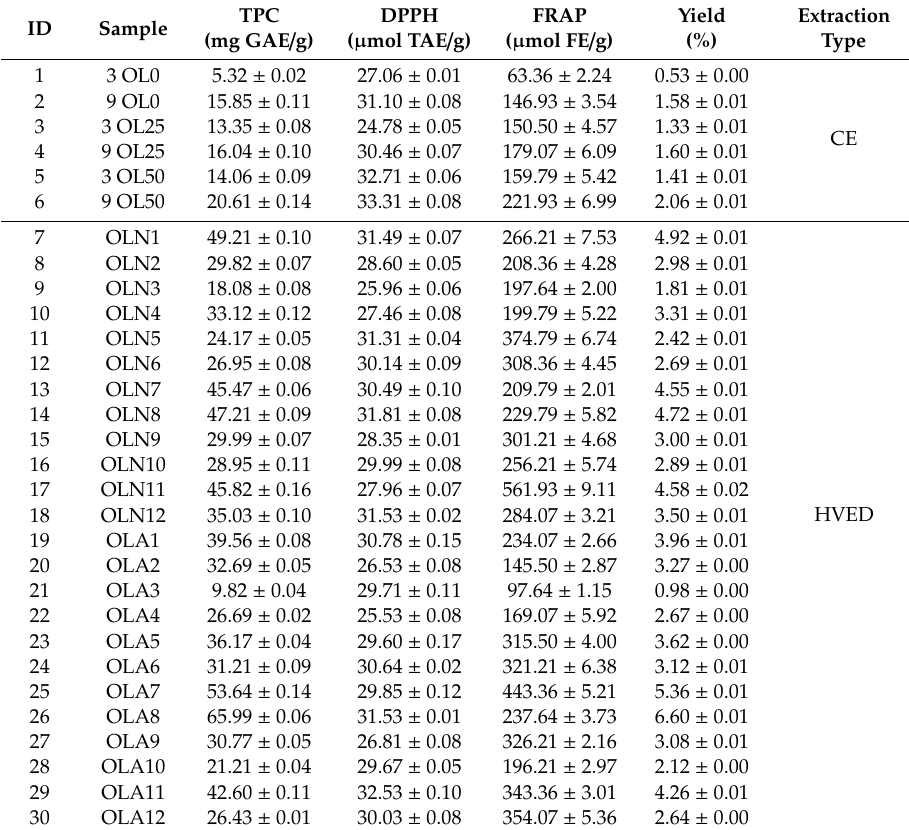
Table 3. Concentrations of total phenolic content (TPC) values, antioxidant capacity (AOC) (2,2-Diphenyl- 2-Picrylhydrazyl - DPPH) and ferric reducing antioxidant power (FRAP)) and extraction yield in extracts produced by conventional extraction (CE) and